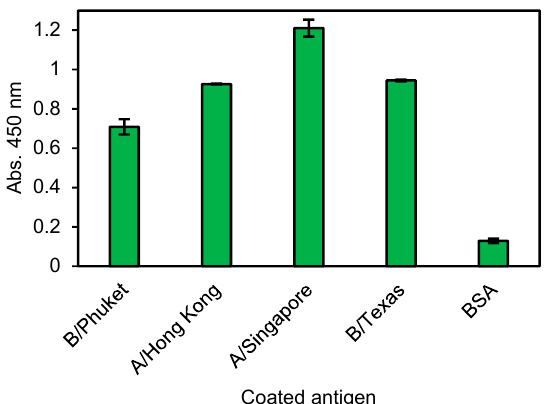
Figure 6. ELISA result of the E. coli expressed and refolded human No. 14 G Zipbody. Each antigen was coated on ELISA plate and 10 ng/ µ L of His tag purified Zipbody was used as the primary antibody. Error bars indicate standard deviations.